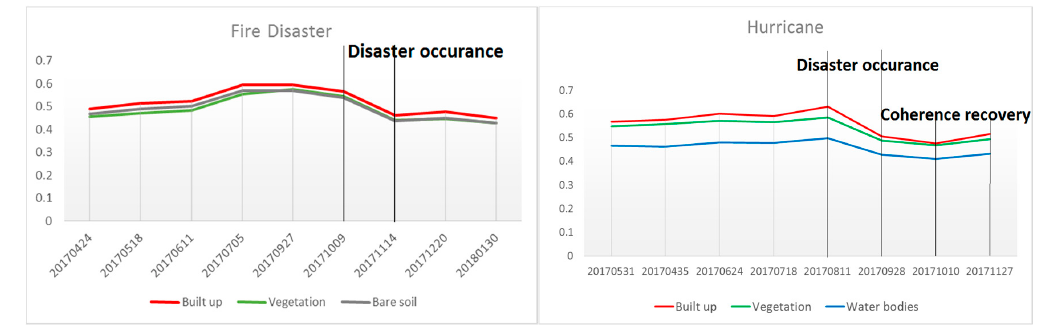
Figure 9. Average coherence graphs for different classes for each disaster.